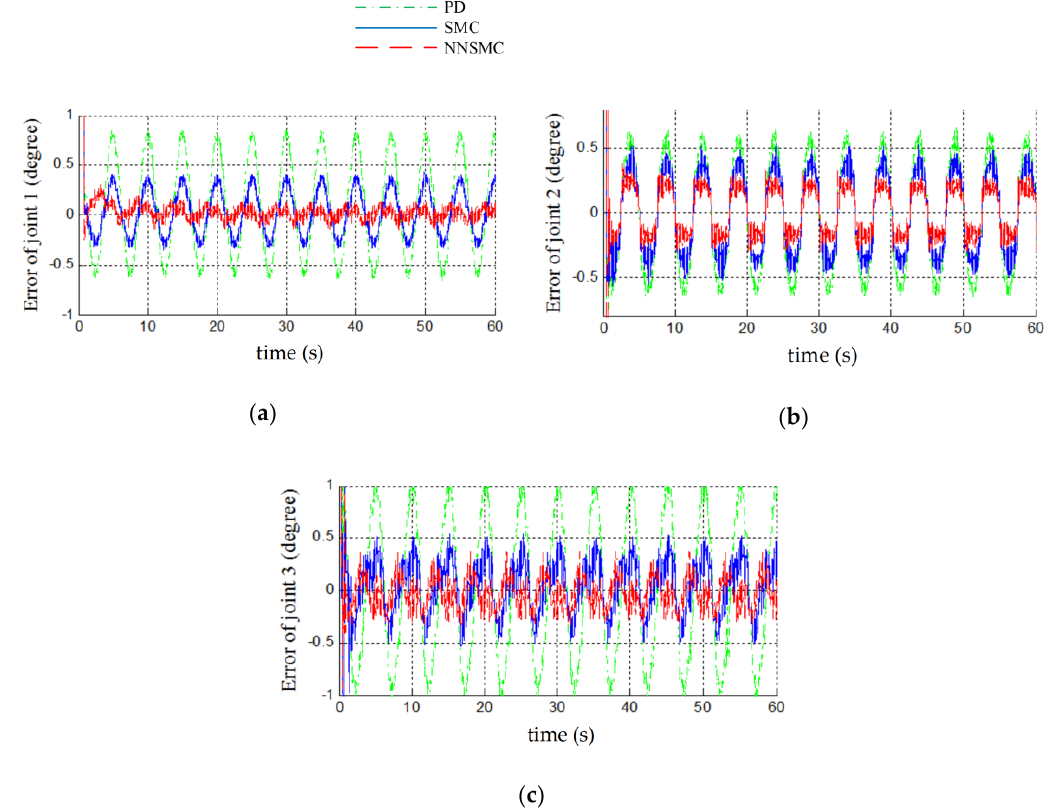
Figure 13. Comparison of the tracking error of the three joints: ( a ) first joint, ( b ) second joint, ( c ) third joint.